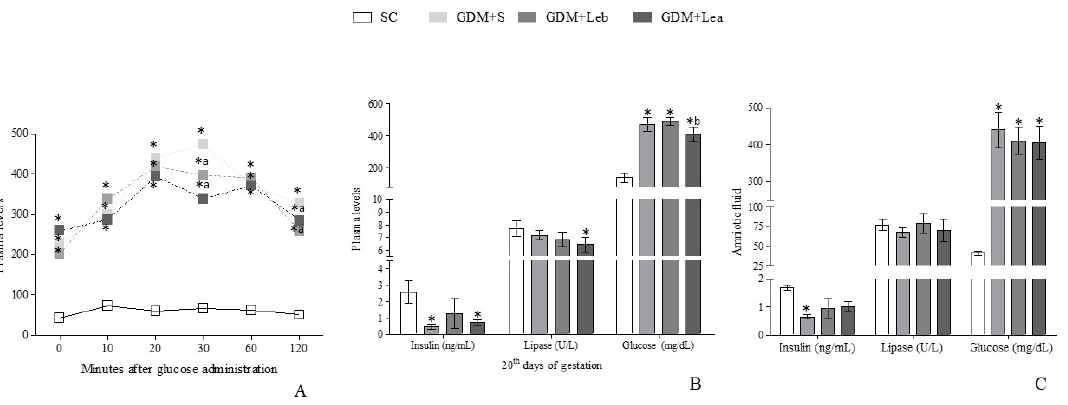
Figure 1. Pancreatic endocrine and exocrine functions tests. ( A ) Oral glucose tolerance test (OGTT) on 17th day of gestation. ( B ) Serum concentration of insulin, lipase and glucose. And Leb is Lentinus edodes before fetus implantation) b is before. ( C ) Amniotic fluid concentration of insulin, lipase and glucose. SC (saline control 0.9%), GDM + S (diabetic + saline solution 0.9%), GDM + Leb (diabetic + 100 mg / kg / day Lentinus edodes before fetus implantation) and GDM + Lea (diabetic + 100 mg / kg / day Lentinus edodes after fetus implantation). Data are presented as mean ± SD ( n = 5). * p < 0.05 in